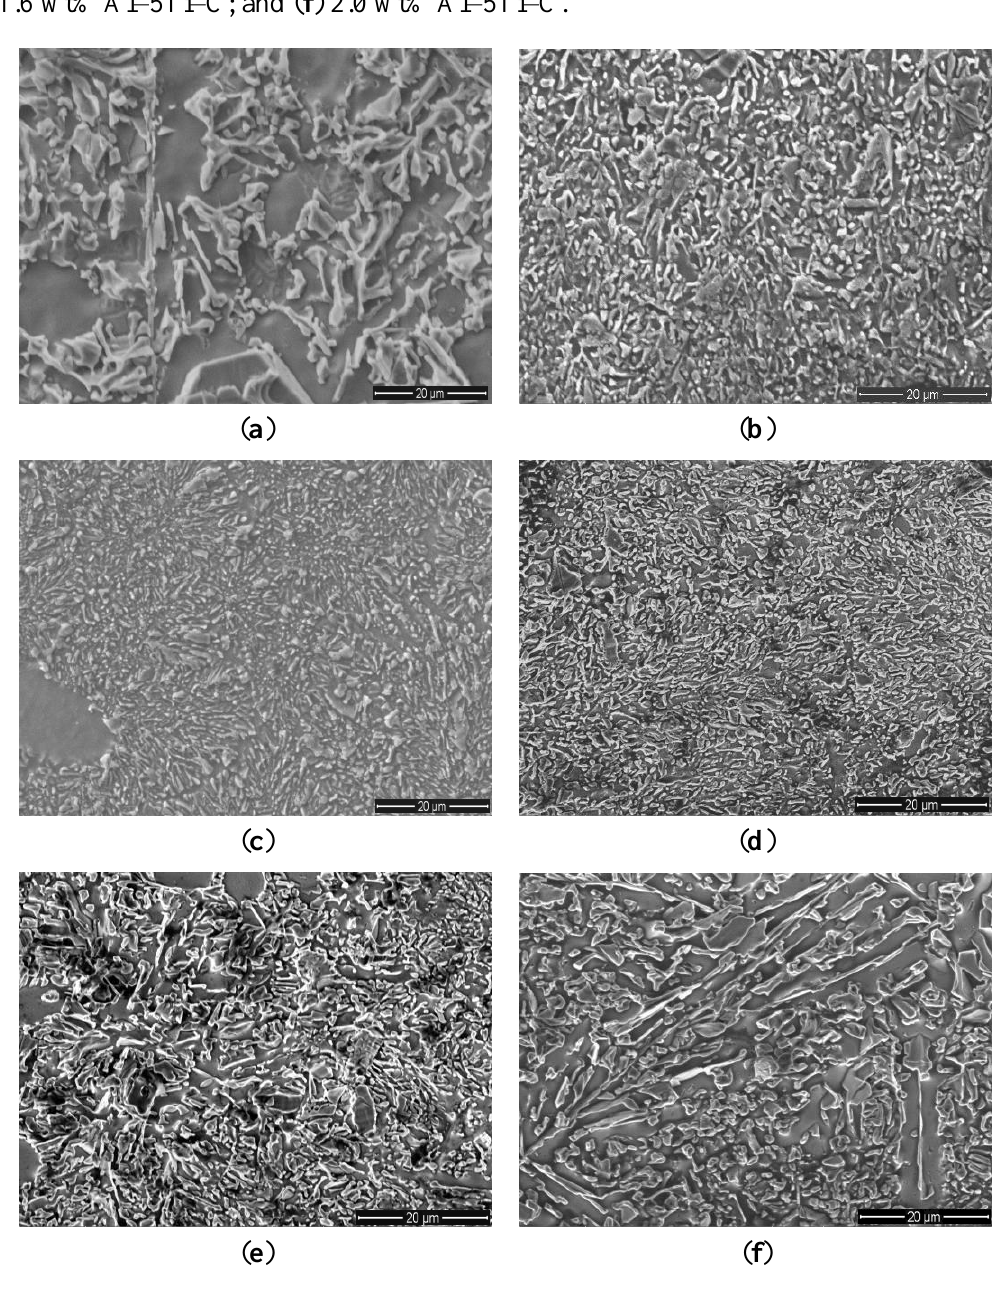
Figure 4. SEM images of eutectic Si crystals in hypereutectic Al–20%Si alloy: (a ) unmodified; ( b ) 0.4 wt% Al–5Ti–C; ( c ) 0.6 wt% Al–5Ti–C; ( d ) 1.0 wt% Al–5Ti–C; ( e ) 1.6 wt% Al–5Ti–C; and ( f ) 2.0 wt%